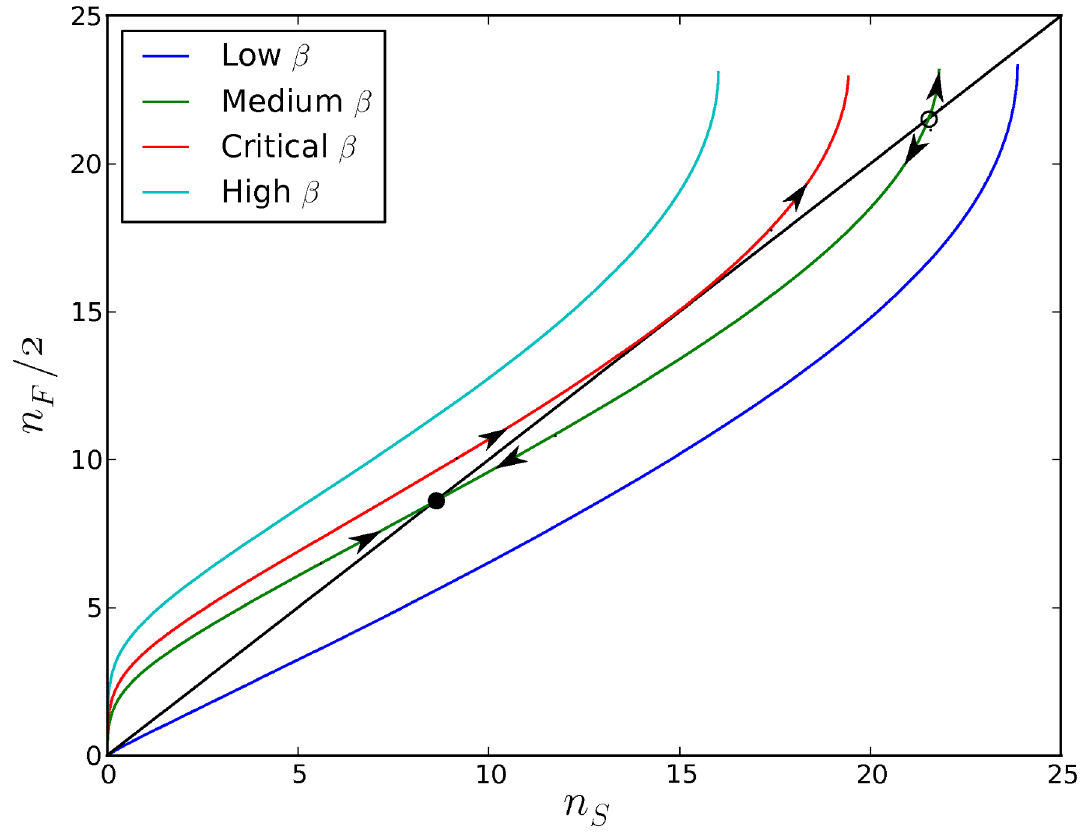
Figure 2. Inter-generational copy number stability. Each curve represents the deterministic relationship between the number of plasmids n S at the beginning of the parent cell cycle and the number of plasmids n F = 2 at the beginning of the daughter cell cycle (assuming equipartitioning during cell division), for a range of initial copy numbers n S and a fixed set of cell and plasmid parameters. The diagonal represents the consistency of copy numbers between parent and daughter cells; points below the diagonal indicate plasmid under-replication, while points above the diagonal indicate plasmid over-replication. The curve’s shape and its point(s) of intersection with the diagonal depend on the plasmid parameter values; curves that do not intersect with the diagonal represent the case of consistent under- or over- replication of plasmids for any initial copy number (blue low b curve and cyan high b curve respectively). The high end of each curve corresponds to a limit beyond which the cell can not sustain its plasmid population due to a negative cell growth rate that leads to cell death. Points marked with circles on the medium b curve (green) represent equilibrium copy numbers; a filled circle indicates stability and the existence of a characteristic copy number, whereas an open circle indicates an unstable equilibrium. The critical b curve (red), which is tangential to the diagonal, represents the limit (edge) of stability, in which the stable and unstable characteristic copy numbers collapse to a singular point.